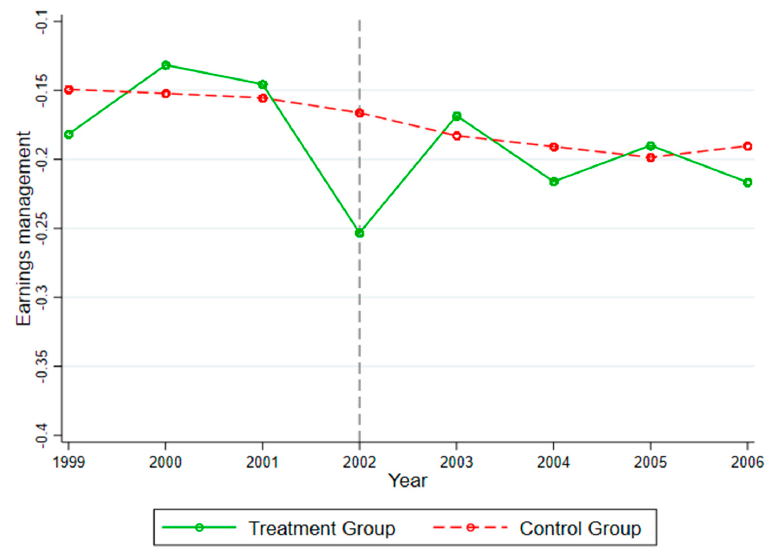
Figure 1. Parallel trend test.